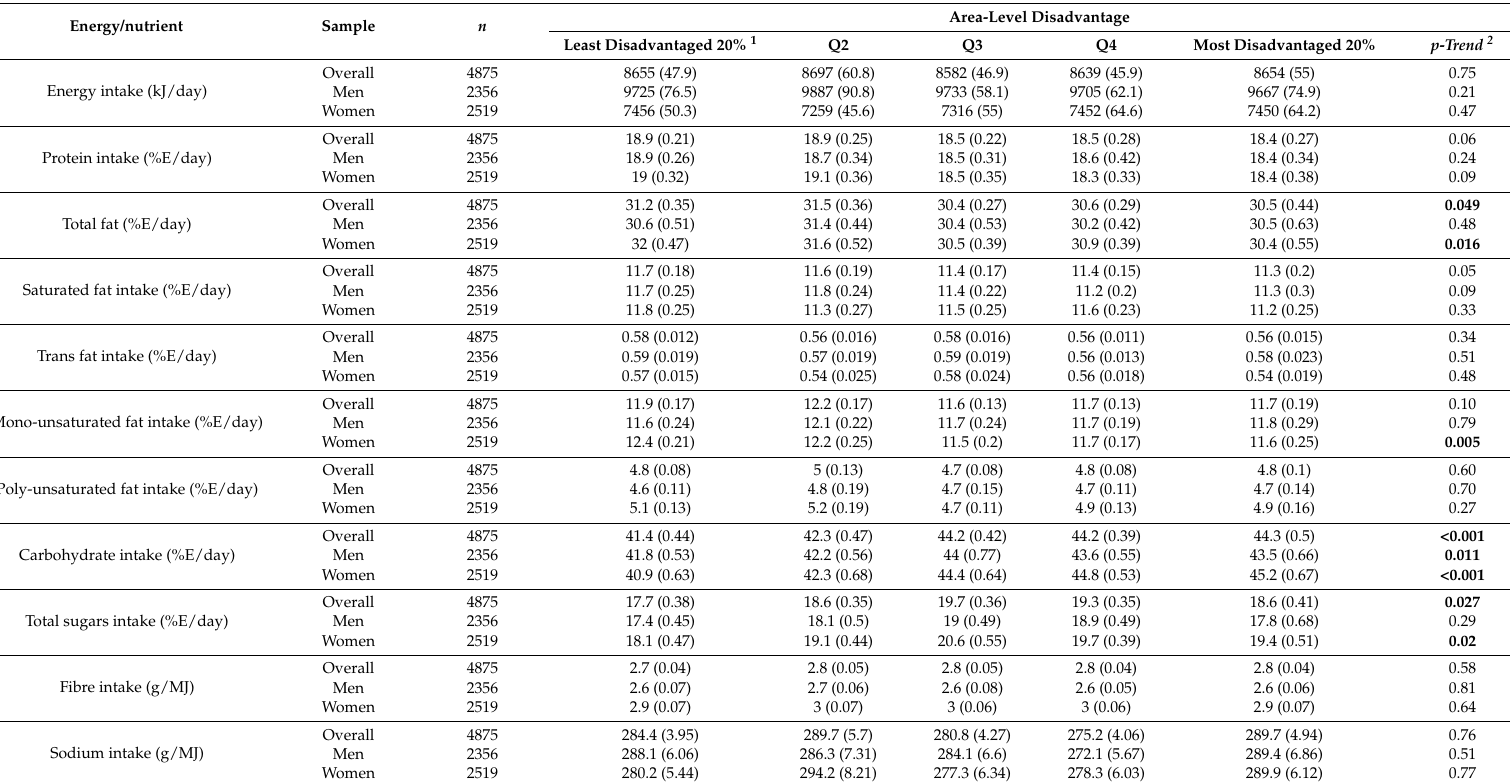
Table 3. Total energy and nutrient intakes by area-level disadvantage in men ( n = 2356) and women ( n = 2519) from the 2011–13 Australian National Nutrition and Physical Activity